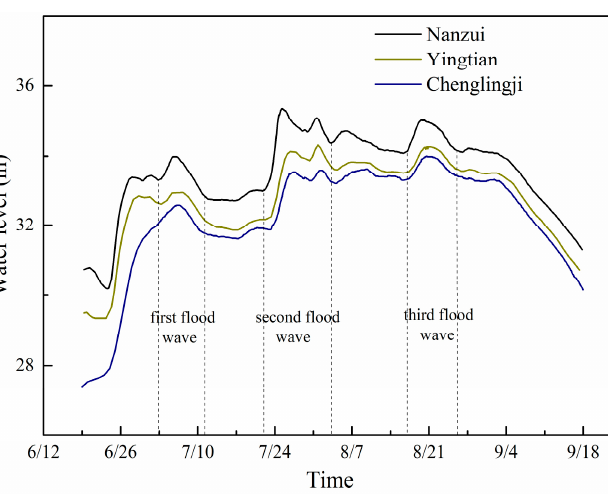
Figure 6. The flooding process in Dongting Lake at selected stations in 1998.